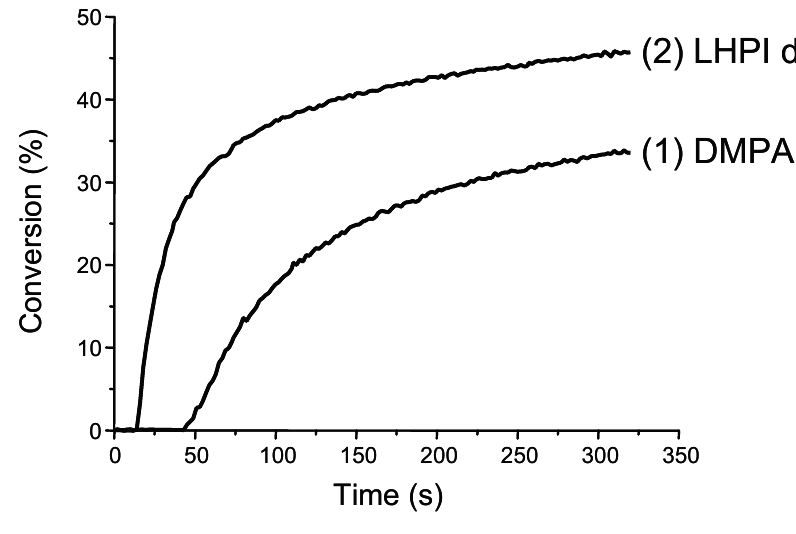
Figure 2. Photopolymerization profiles of trimethylolpropane triacrylate (TMPTA) in laminate upon a halogen lamp exposure in the presence of ( 1 ) DMPA or ( 2 ) the corresponding Tr-DMPA LHPI (from [57]).